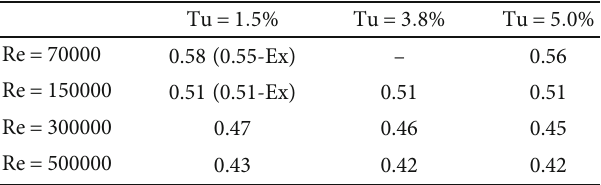
x / L ) with 12 positions (